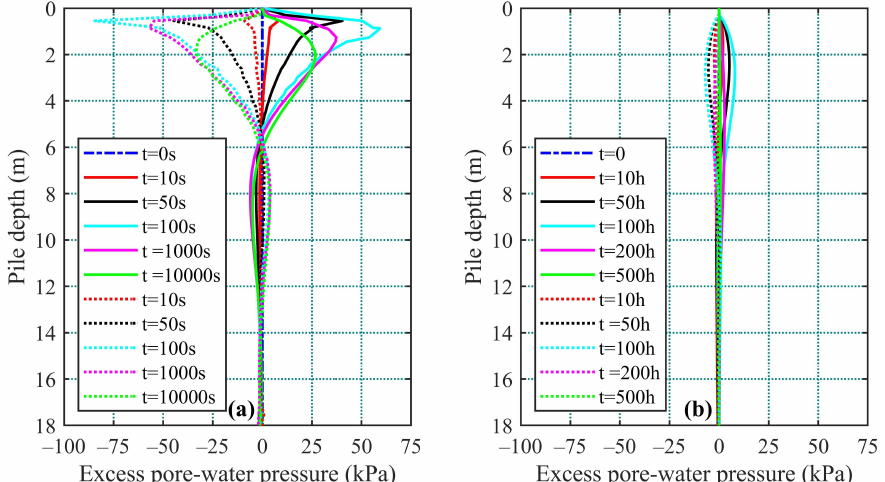
Figure 2. Generation and dissipation of excess pore water pressure at Sec. A-A and Sec. B-B (see Figure 1a) during the loading of the pile: ( a ) fast loading rate: 2 kN/s (undrained); and ( b ) slow loading rate: 2 kN/h (partially